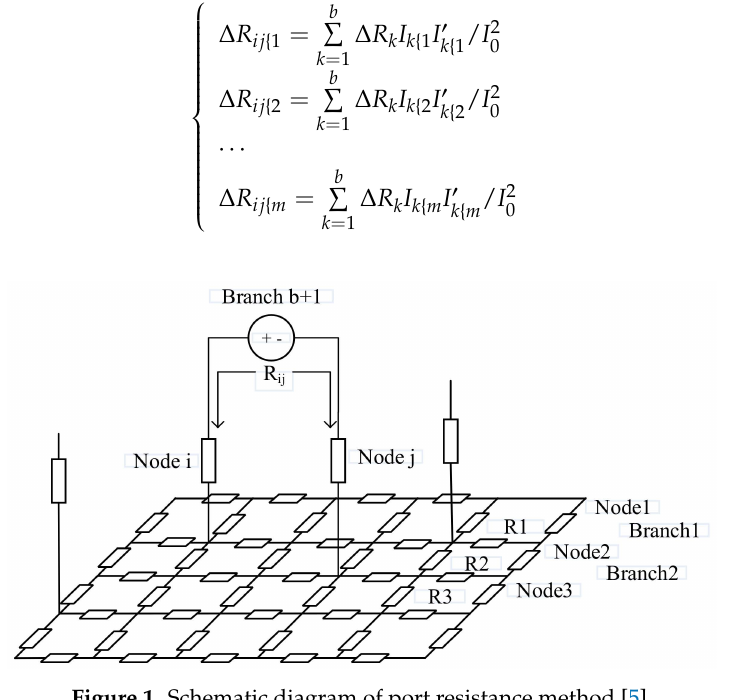
Figure 1. Schematic diagram of port resistance method